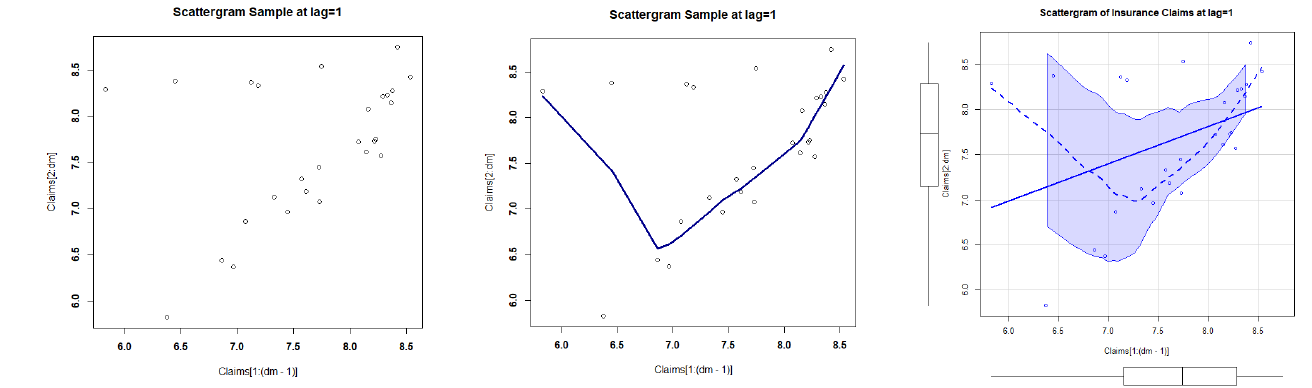
Figure 7. The NKDE graph ( top left graph ), the Q-Q graph ( top right graph ), the TTT graph ( bottom left graph ), and the box graph ( bottom right graph ) for the claims data.